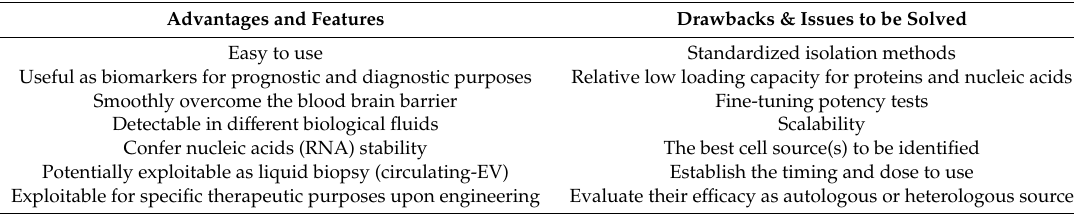
Table 2. Major benefits and drawbacks of EV treatment